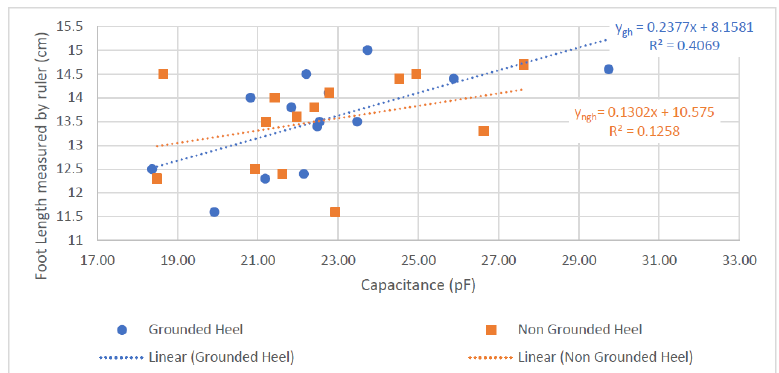
Figure 25. Graph of Foot Length and Capacitance.